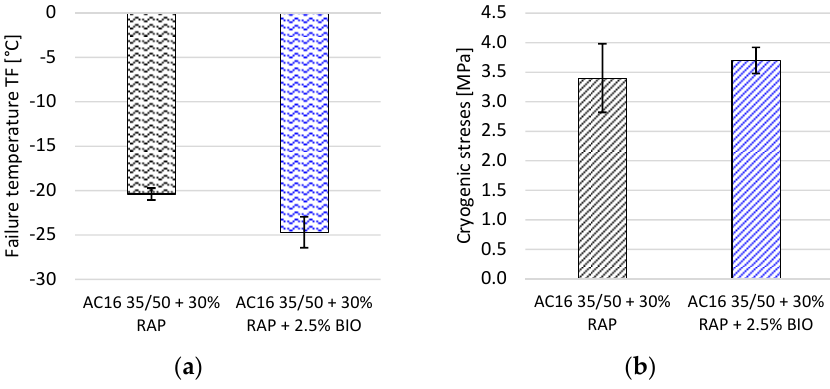
Figure 8. Low temperature characteristic of asphalt mixtures: ( a ) failure temperature; ( b ) cryogenic stress.